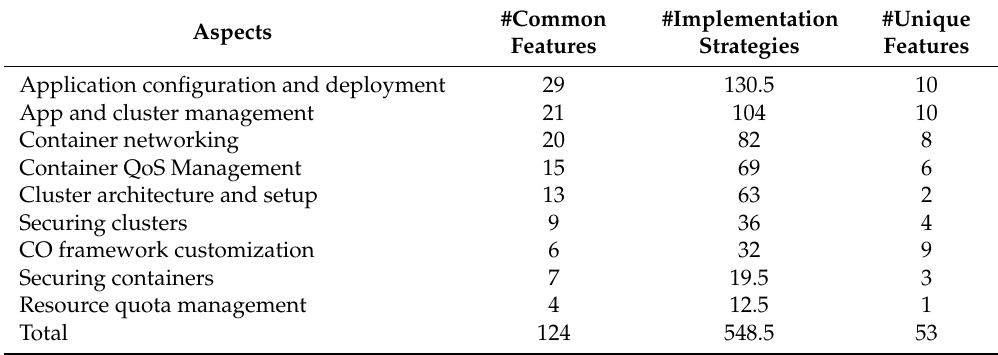
Table 3. Functional aspects ranked according to the number of common feature implementation strategies by CO frameworks. If a common feature is partially supported by or only supported in the commercial version of a CO framework, the implementation strategy is counted as 1 number of common and unique features of each functional aspect are also presented.